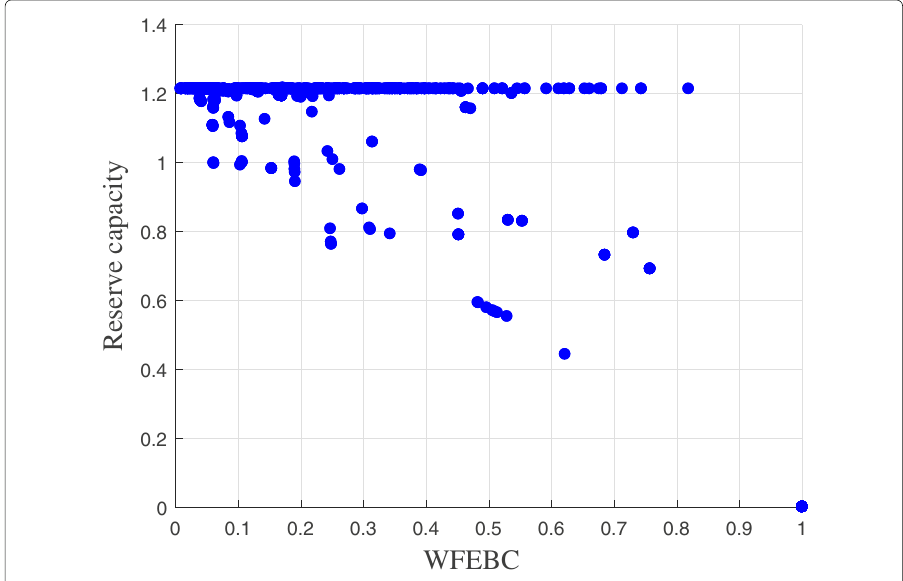
Fig. 10 Analysis of the correlation between reserve capacity and WFEBC links values for BWFL. The reserve capacity of the individual links of the core model of BWFL is plotted against their WFEBC value